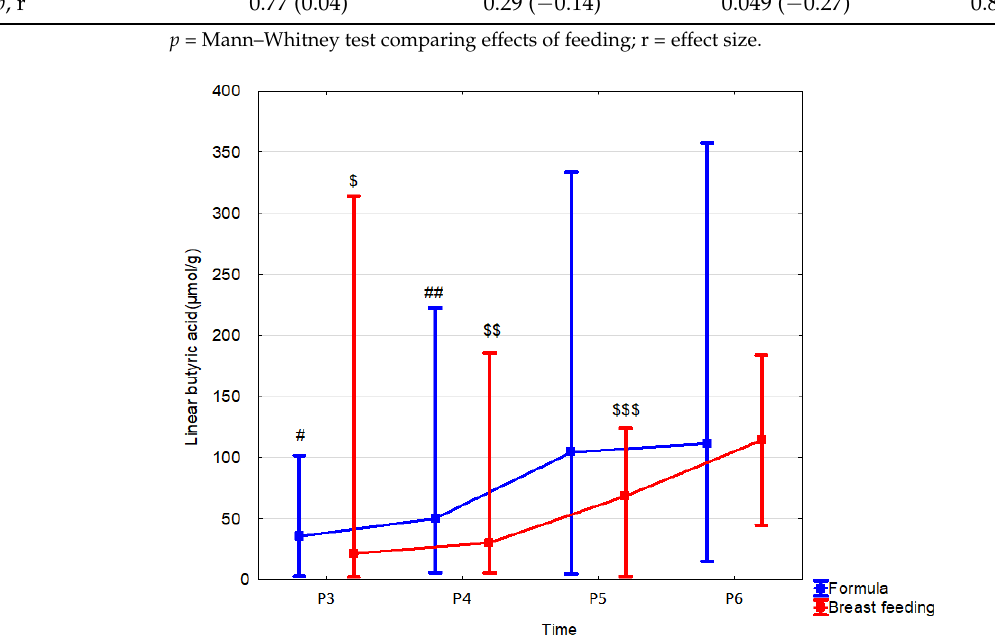
Figure 5. Linear butyric acid (median) in children over time according to the type of feeding: formula (blue line) or breast feeding (red line). Legend: Error bars represent range. Wilcoxon paired tests regarding time, # (formula), $ (breast feeding): #, $: p < 0.05 P3 vs. P5 and P6; ##, $$: p < 0.05 P4 vs. P5 and P6; $$$ p < 0.05 P5 vs. P6.